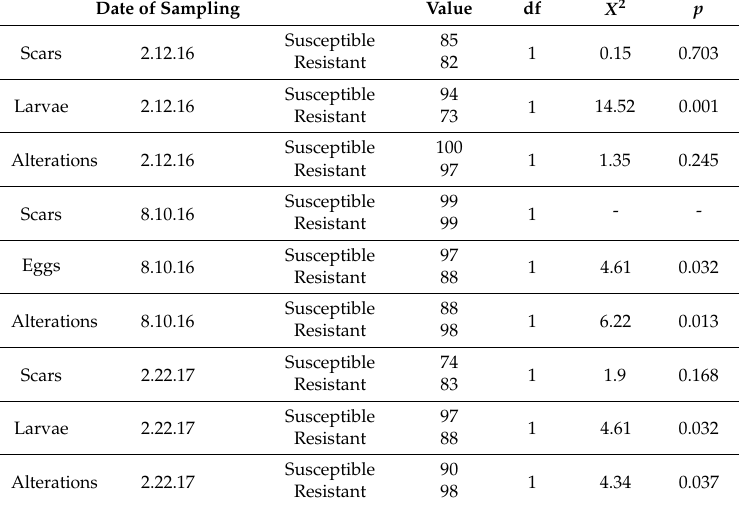
p = with Yates’ correction, values <0.05 indicate significance.